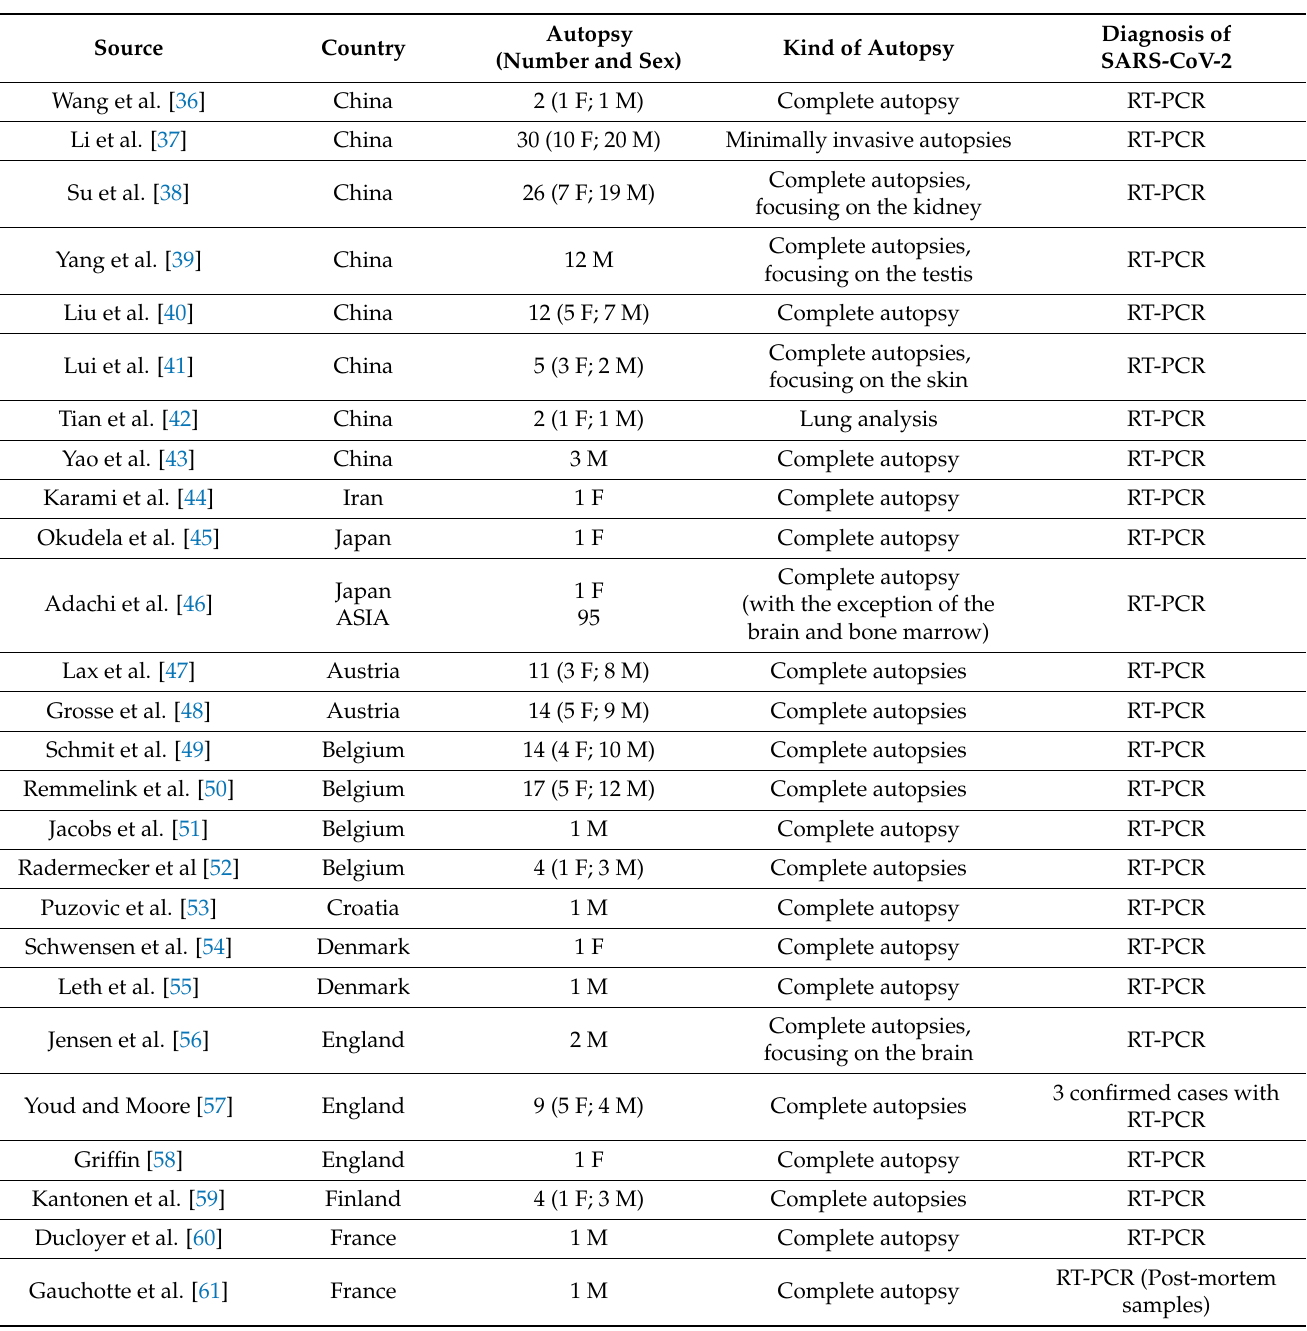
Table 3. General data obtained analyzing the studies included in this literature review matching the keywords “Autopsy” OR “Post-mortem” AND “SARS-CoV-2” (severe acute respiratory syndrome coronavirus 2) OR “COVID-19” (coronavirus disease